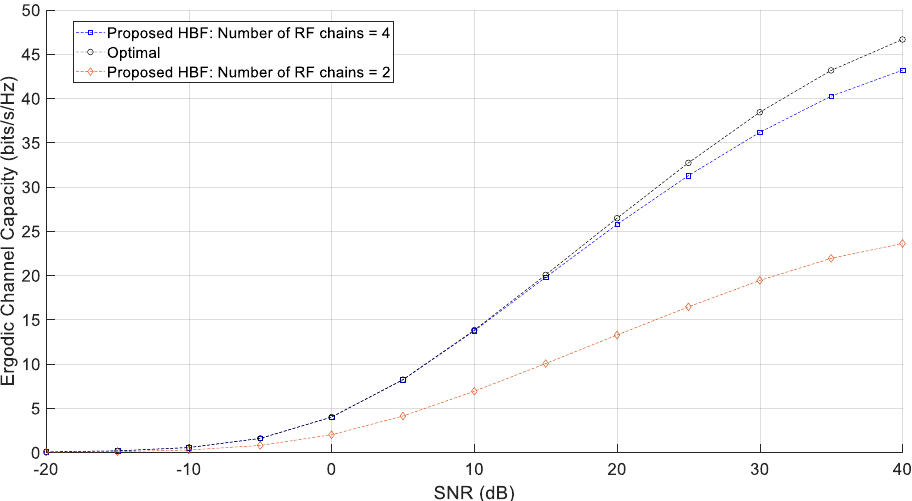
Figure 7. Ergodic channel capacity of the proposed HBF for different number of RF chains.